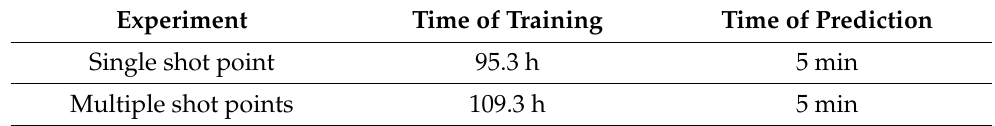
Table 1. Time of calculation in one anomaly without fault